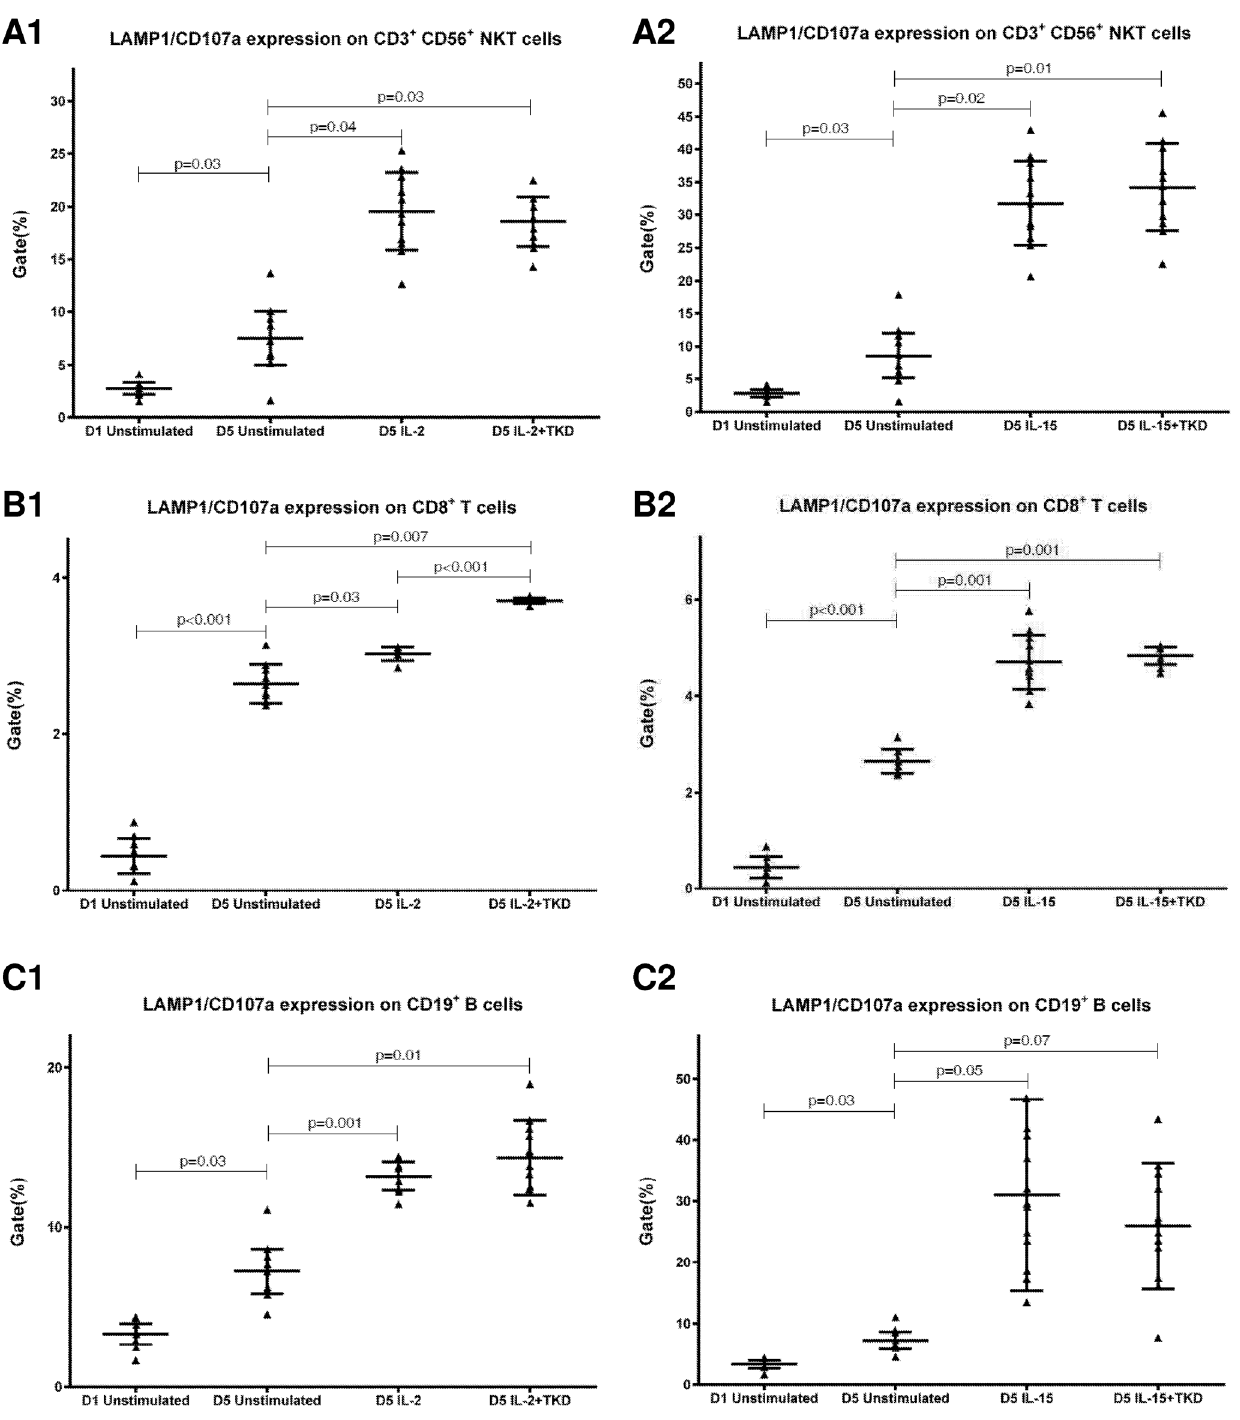
Fig 11. The effect of IL-2, IL-15, IL-2/TKD and IL-15/TKD on the expression of LAMP1 receptor in peripheral blood mononuclear cells of healthy individuals — the proportion of CD3 + CD56 + NKT cells, CD8 + T cells and CD19 + B cells expressing an appropriate receptor. The expression of LAMP1 receptor on CD3 + CD56 + NKT cells, CD8 + T cells and CD19 + B cells was examined within the fraction of unstimulated and stimulated mononuclear cells derived from 10 healthy individuals. Data are presented as means ± standard error. In total, the study cohort consisted of 52 Caucasian healthy individuals.